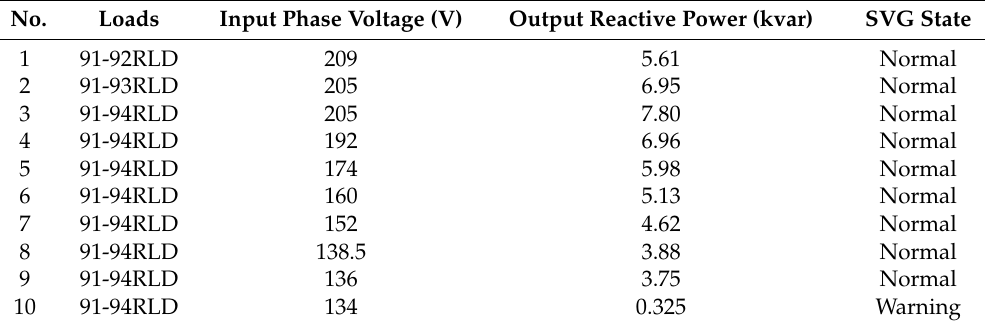
Table 5. Results of SVG input voltage range testing.